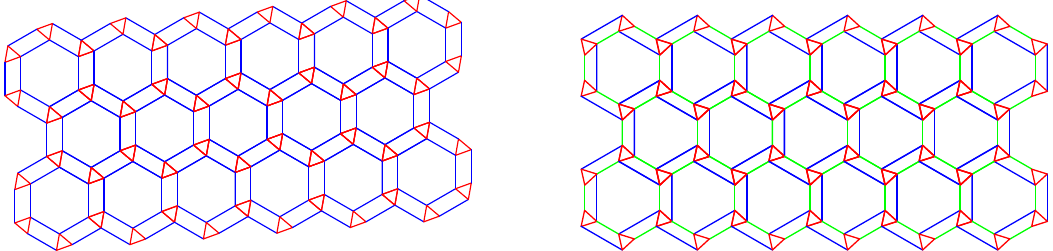
Fig. 7: Families of monocoronal tilings with one triangle, two quadrilaterals, and one hexagon.